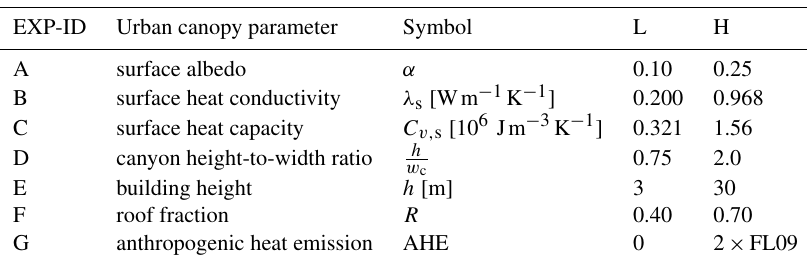
Table 2. Overview of parameter sensitivity experiments. Seven couples of experiments (AL, AH, BL, BH, CL, CH, DL, DH, EL, EH, FL, FH, FL, GH) are performed for which the default urban canopy parameters are modified to the values in the low (L) and high (H) columns. Except for the AHE, L and H correspond to the minimum and maximum values of the urban canopy parameter ranges for the local climate zones of compact low-rise and mid-rise defined in Stewart and Oke (2012). For the GL scenario, the AHE is set to 0Wm − 2 . For the GH scenario, AHE multiplied by 2 compared to the default setup for which the data set and methodology of Flanner (2009, denoted as FL09 in the table) are